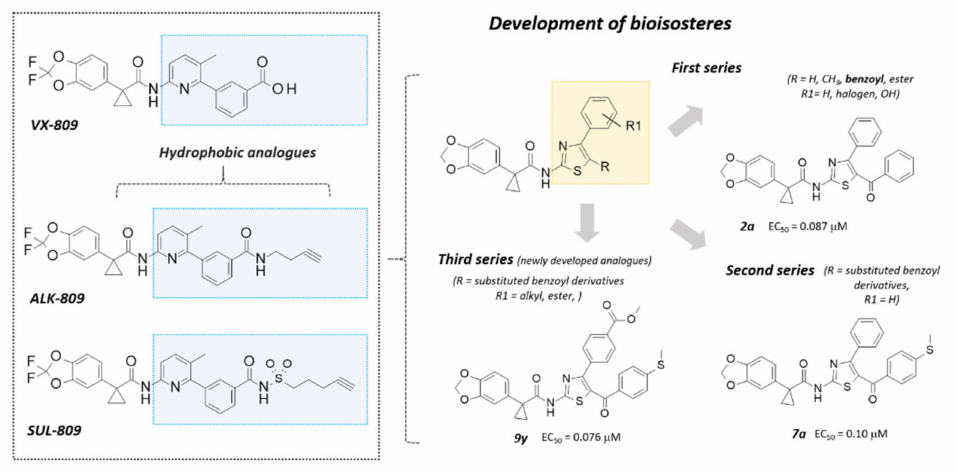
Figure 2. Chemical structure of VX-809 and of the related congeners ALK-809 and SUL-809. Structural variations featured by the in-house hybrids are also